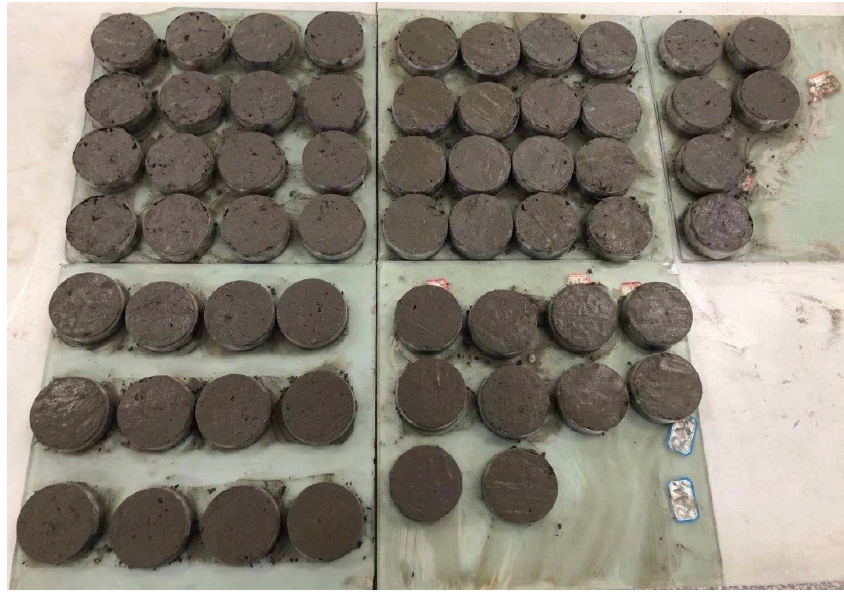
Figure 2. Round concrete specimens for direct shear test.